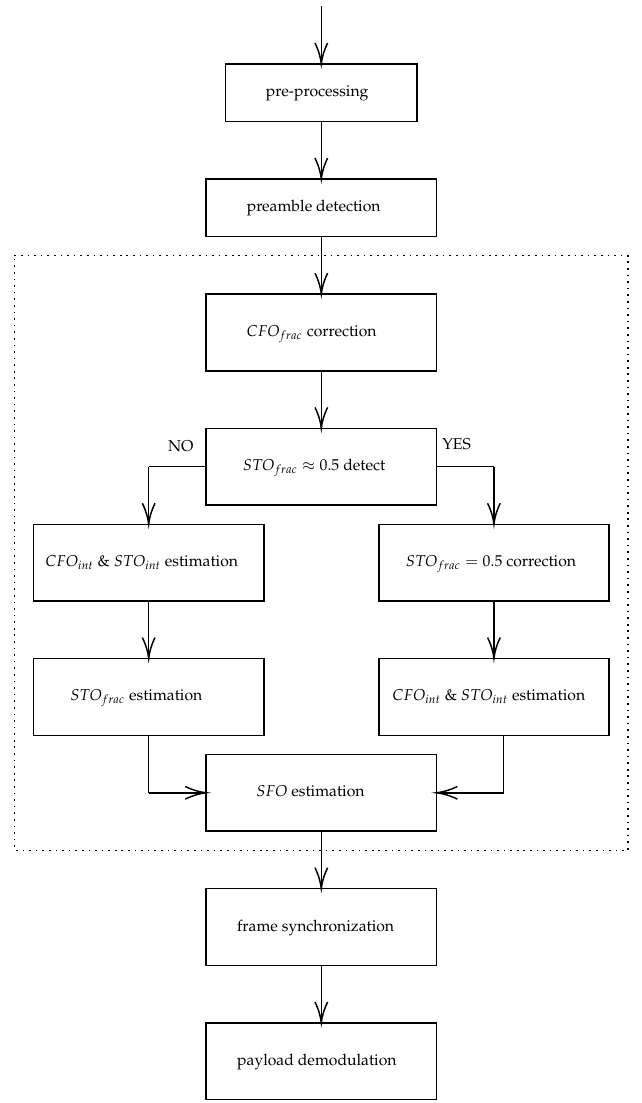
Figure 6. Illustration of the LoRa synchronization front-end adapted to the self-jamming scheme.